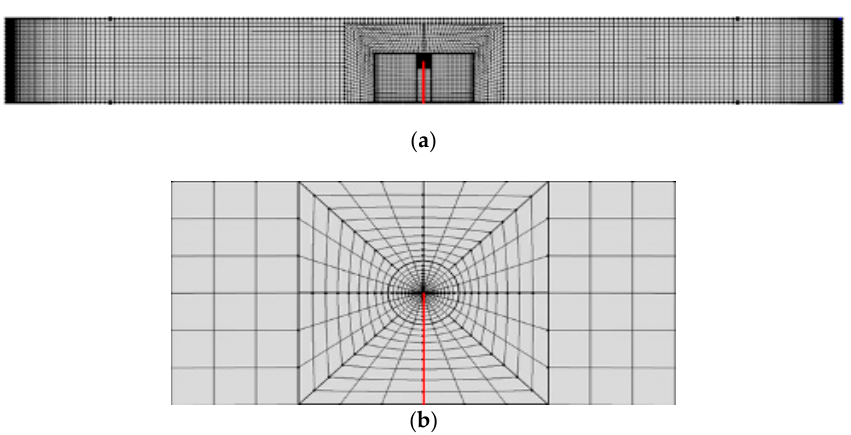
Figure 4. ( a ) The finite element mesh for a PSCs specimen and ( b ) its locally refined meshes at the crack tip.